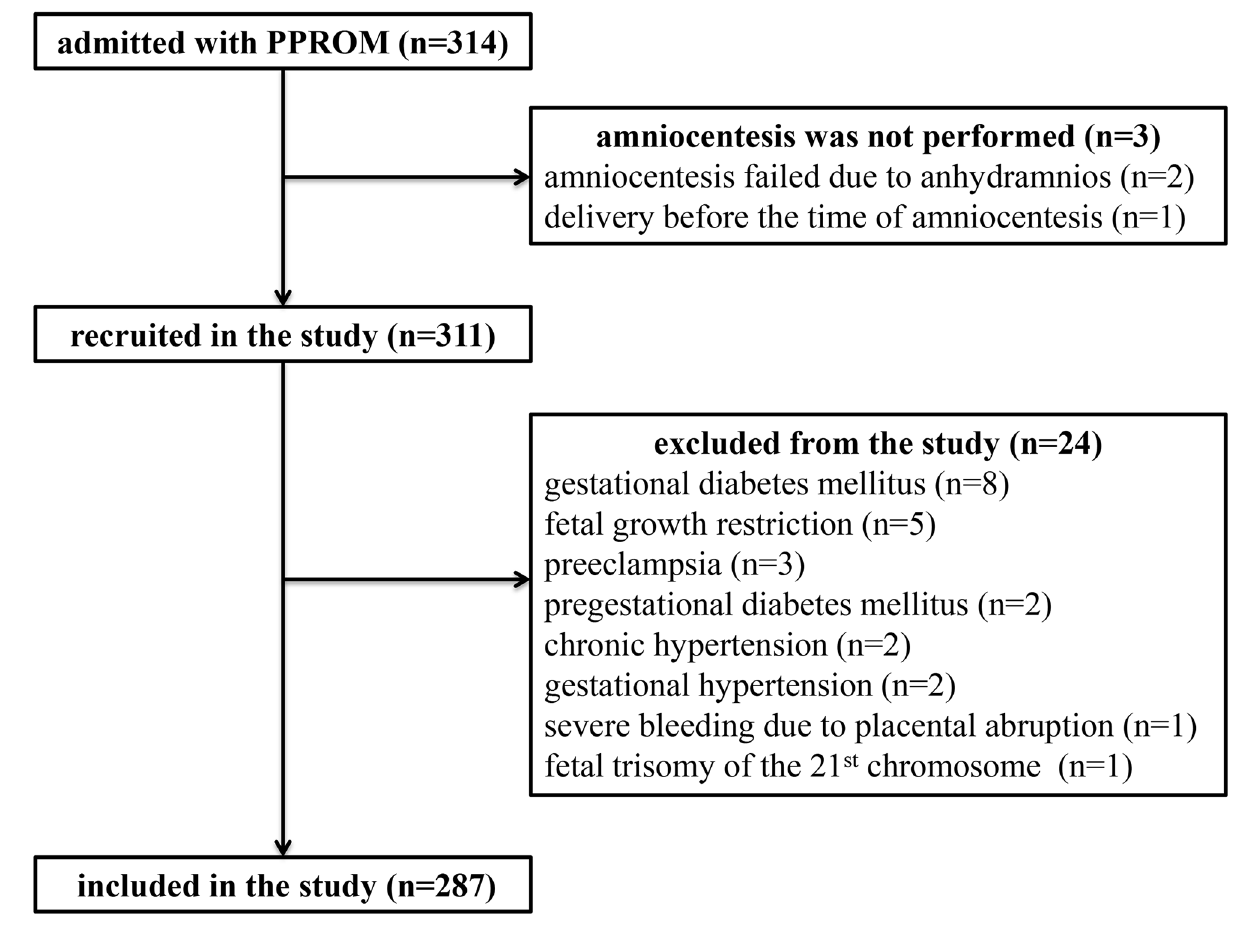
Fig 1. Flow diagram describing the selection of women.